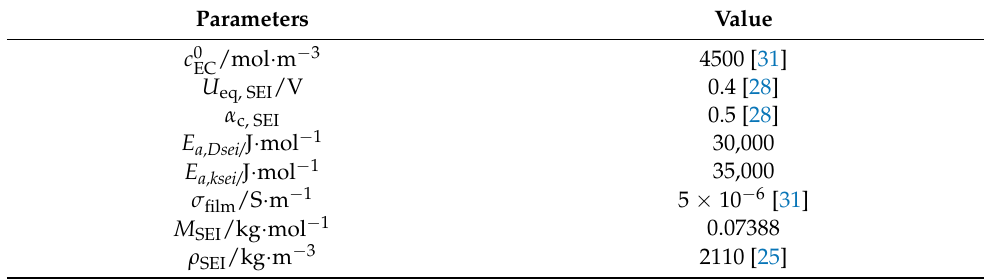
Table 2. Parameters used in the aging model.